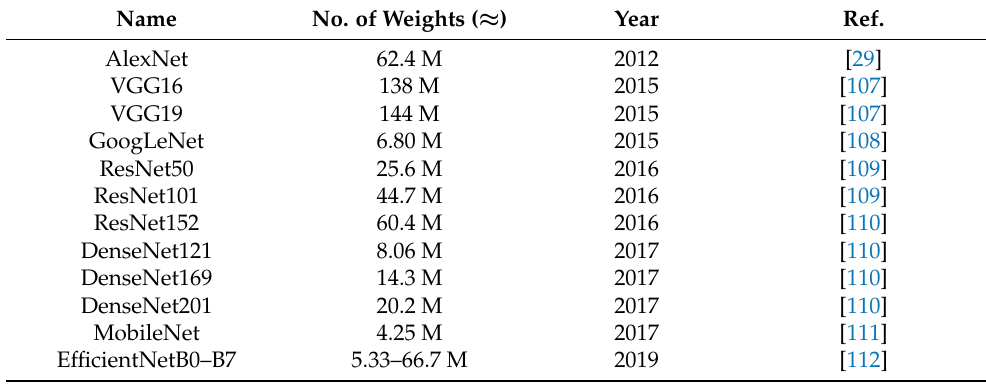
Table 2. Summary table of CNN